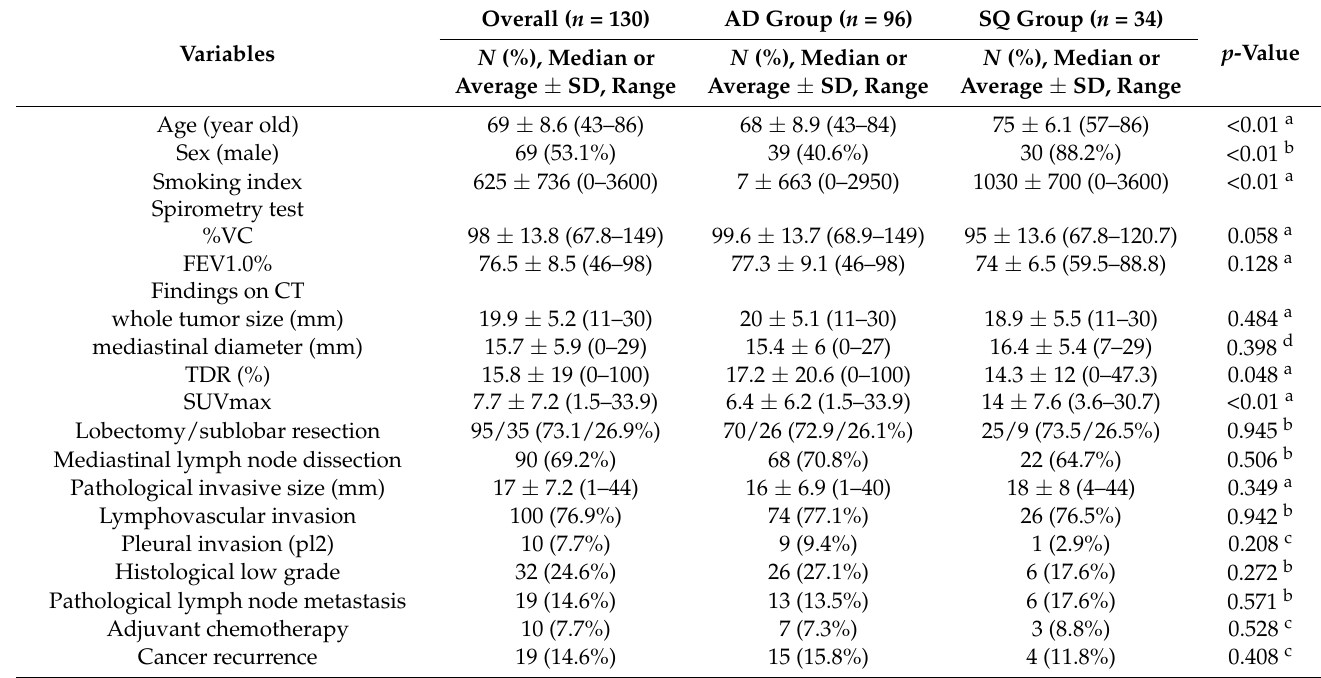
Table 1. Comparison between adenocarcinoma (AD) and squamous cell carcinoma